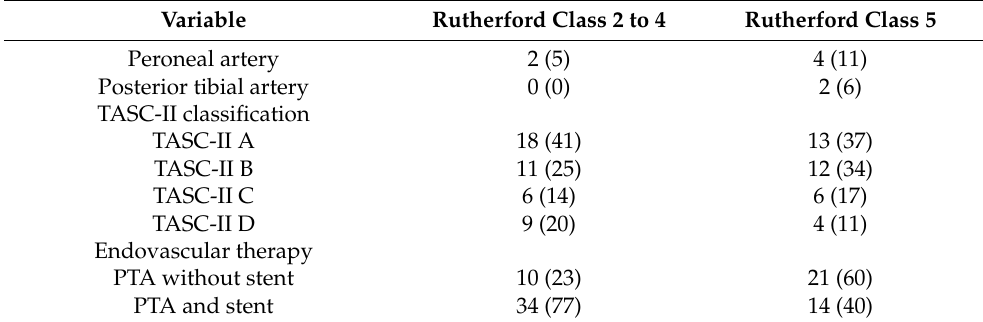
Table 2. Cont . Variable Rutherford Class 2 to